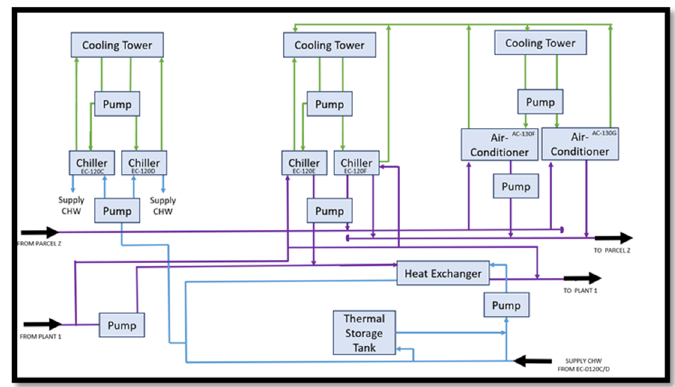
Figure 2. Configuration of 4 chillers at a large Gas District Cooling plant using the block diagram .